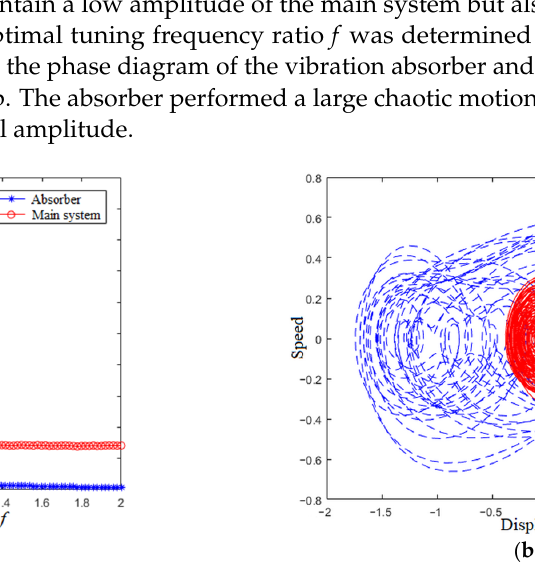
Figure 9. Response amplitude and phase diagram of two vibrators in the case of off-resonance ω =